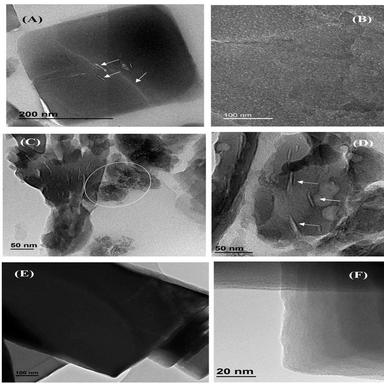
TEM images of (A, B) Aged Meso-0.15, (C, D) One-pot Meso and (E, F) Micro SAPO-34 CHA-based materials.